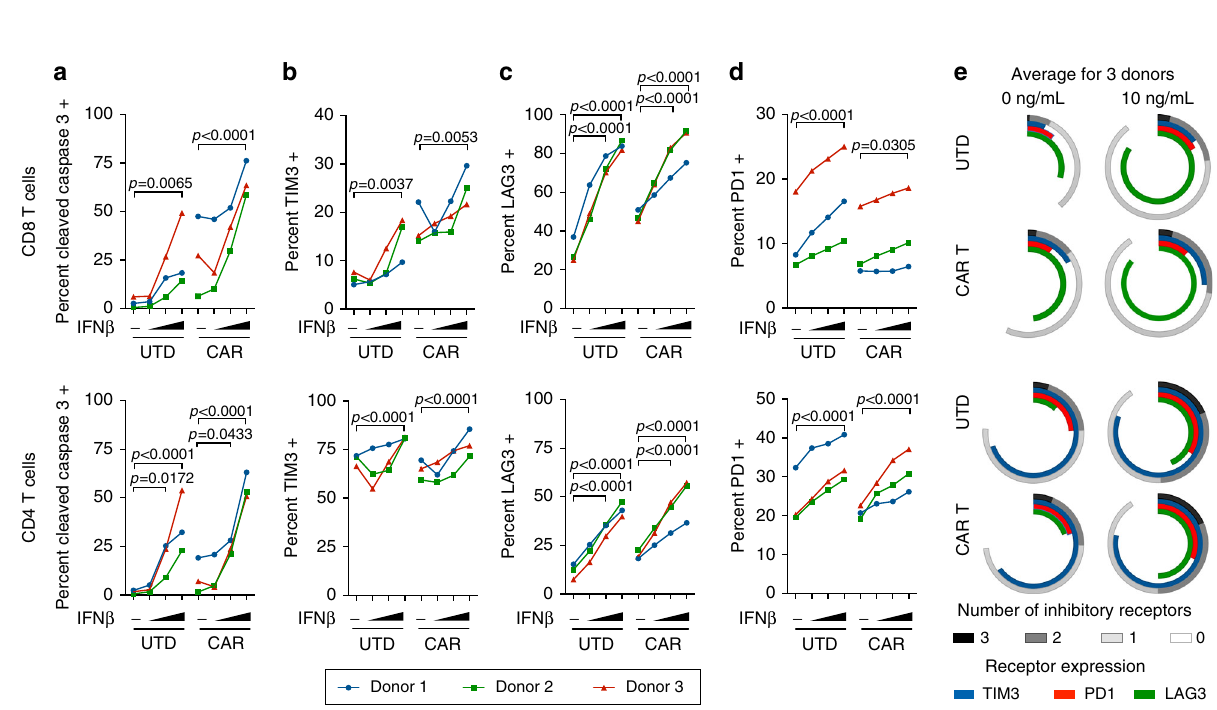
Fig. 5 Recombinant IFN β promotes human CAR T cell apoptosis and inhibitory receptor expression. CAR and untransduced (UTD) T cells from three healthy donors were cultured in the absence or presence of human IFN β (0, 0.1, 1, or 10 ng/mL) for 48 h and analyzed for the expression of ( a ) cleaved caspase 3, ( b ) TIM3, ( c ) LAG3, and ( d ) PD1. e Average expression of individual and combinations of inhibitory receptors for three donors. Data are representative of two independent experiments. Data points indicate the average of two technical replicates for each donor and P -values were determined for all three donors using a two-way repeated measures ANOVA with a Tukey multiple comparisons post-test. Source data are provided in the Source Data